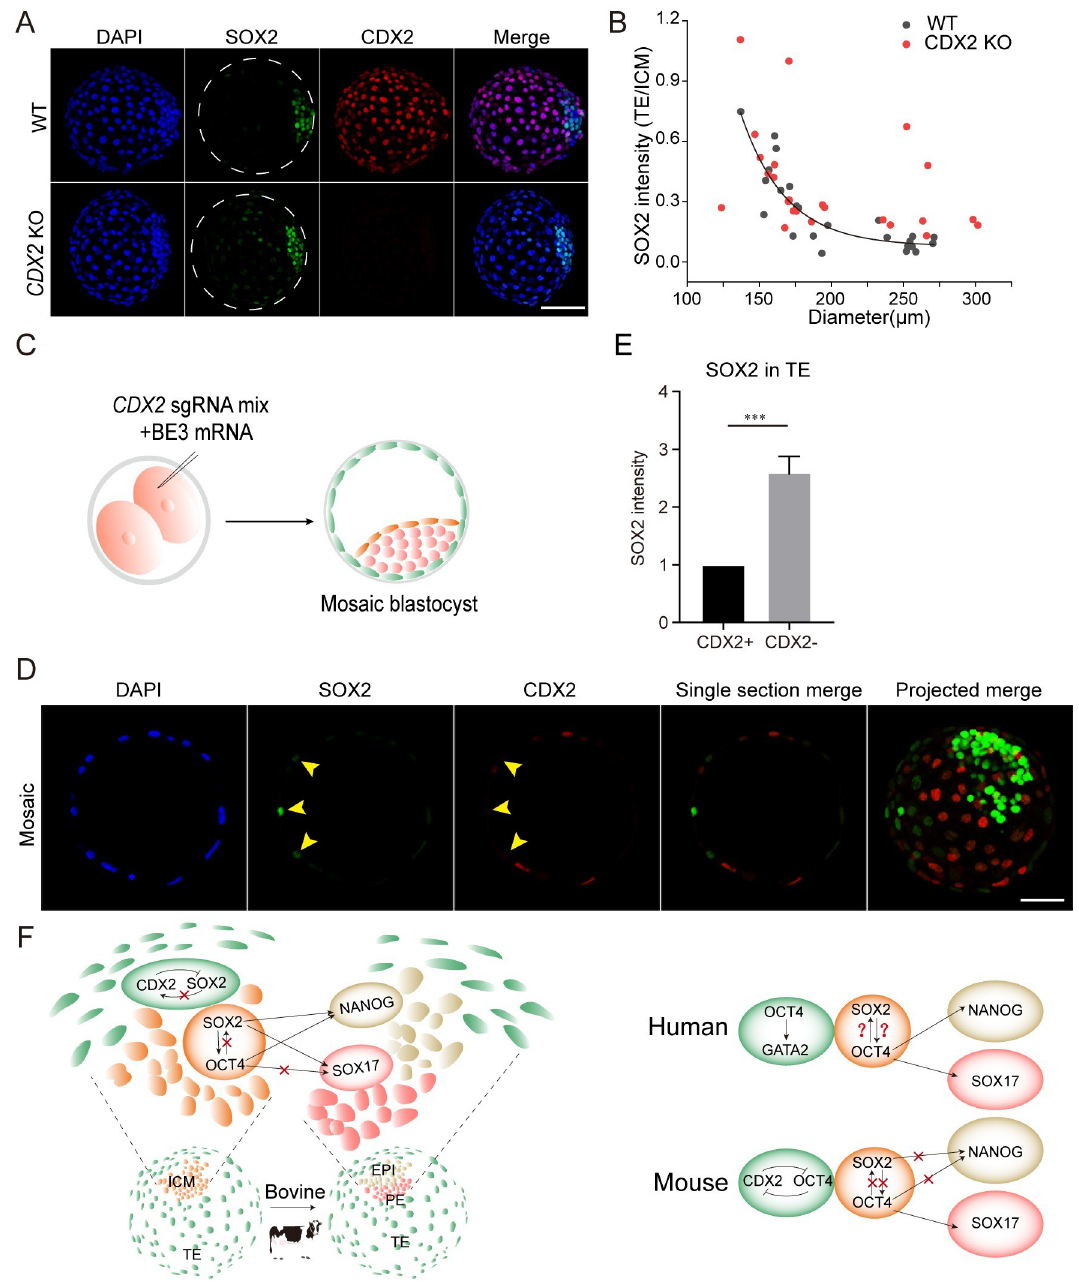
Fig 6. CDX2 is required for the restricted expression of SOX2 in the ICM of bovine late blastocysts. A. Immunostaining analysis of SOX2 in trophectoderm (TE) between WT and CDX2 KO blastocysts. Scale bar = 50 μ m. Seven replicates of 4–8 blastocysts per group. B: The correlation between SOX2 intensity (TE/ICM) and diameter in WT and CDX2 KO blastocysts. C. Experimental scheme to produce CDX2 mosaic bovine blastocysts. D. Immunostaining analysis of SOX2 levels in CDX2 - TE cells relative to CDX2 + TE cells. Green: SOX2; Red: CDX2; Scale bar = 50 μ m. E. Statistical analysis of SOX2 intensity in CDX2 - TE cells relative to CDX2 + TE cells. n = 12. Asterisks refer to significant differences ( � :P < 0.05; �� :P < 0.05; ��� : P < 0.001). F. Summary and working model of functional relationship between SOX2 and other core lineage-specific genes in human, mouse and bovine blastocysts.